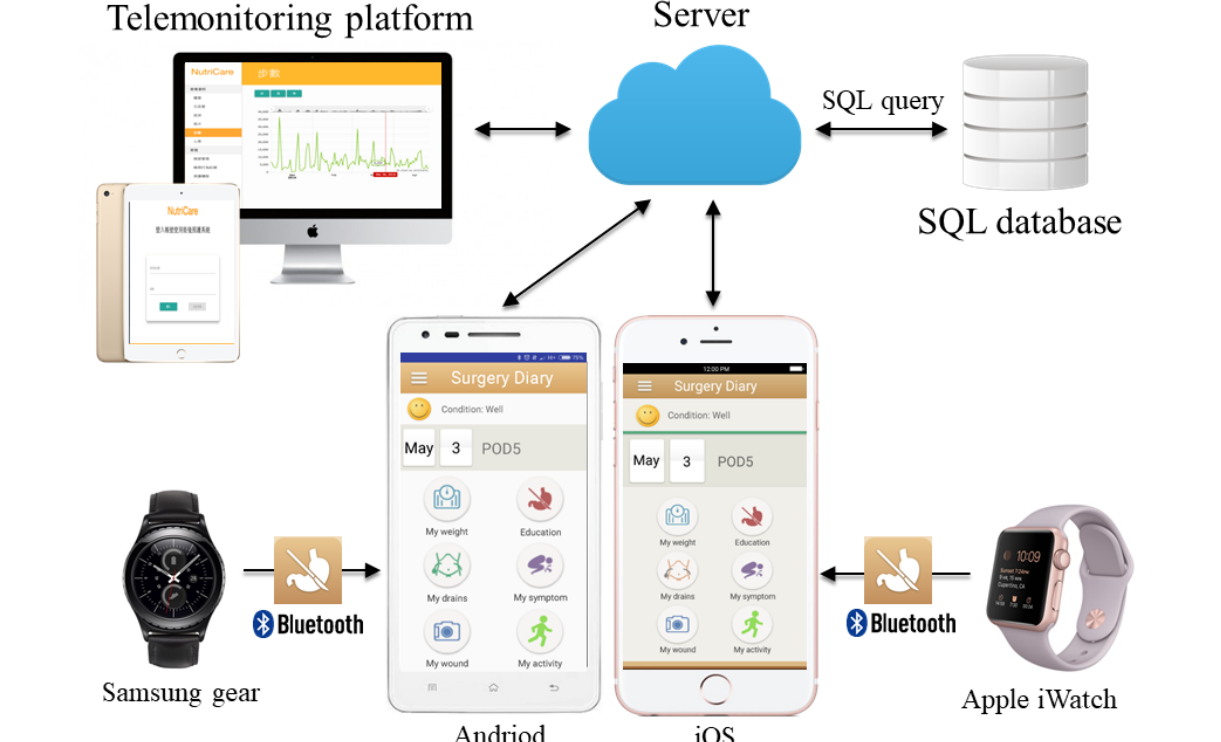
Figure 2. The system architecture: the wearable device for recording physical activity (number of steps) is Apple Watch for iOS and Samsung Gear S2 for Android. The wearable devices connected and sent data to the original customized apps in mobile phones, which were further connected to our designed app. SQL: standard database